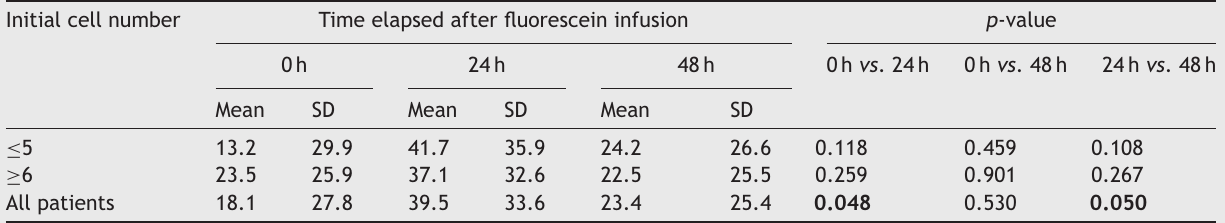
Percentage of neutrophils according to progression of time and initial cell number. Initial cell number